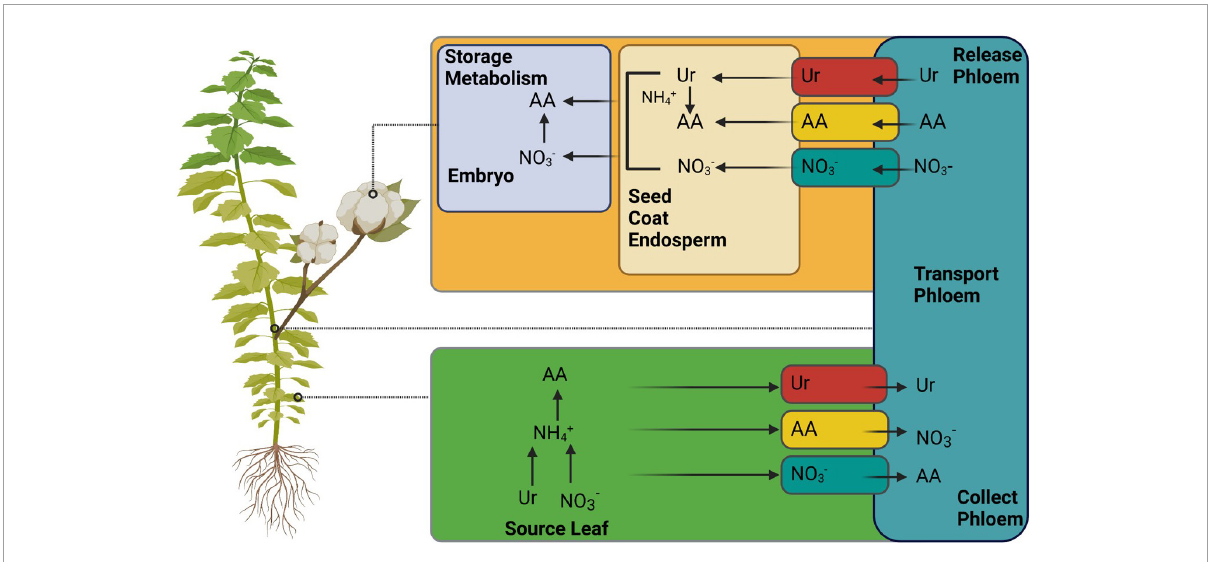
FIGURE5 Illustrates the mechanism of nitrogen remobilization from source (leaf) to sink (seed). Various known and unknown transporters are involved in portioning, as mentioned in Tegeder and Masclaux-Daubresse (2018). AA, amino acids. The figure created with Biorender